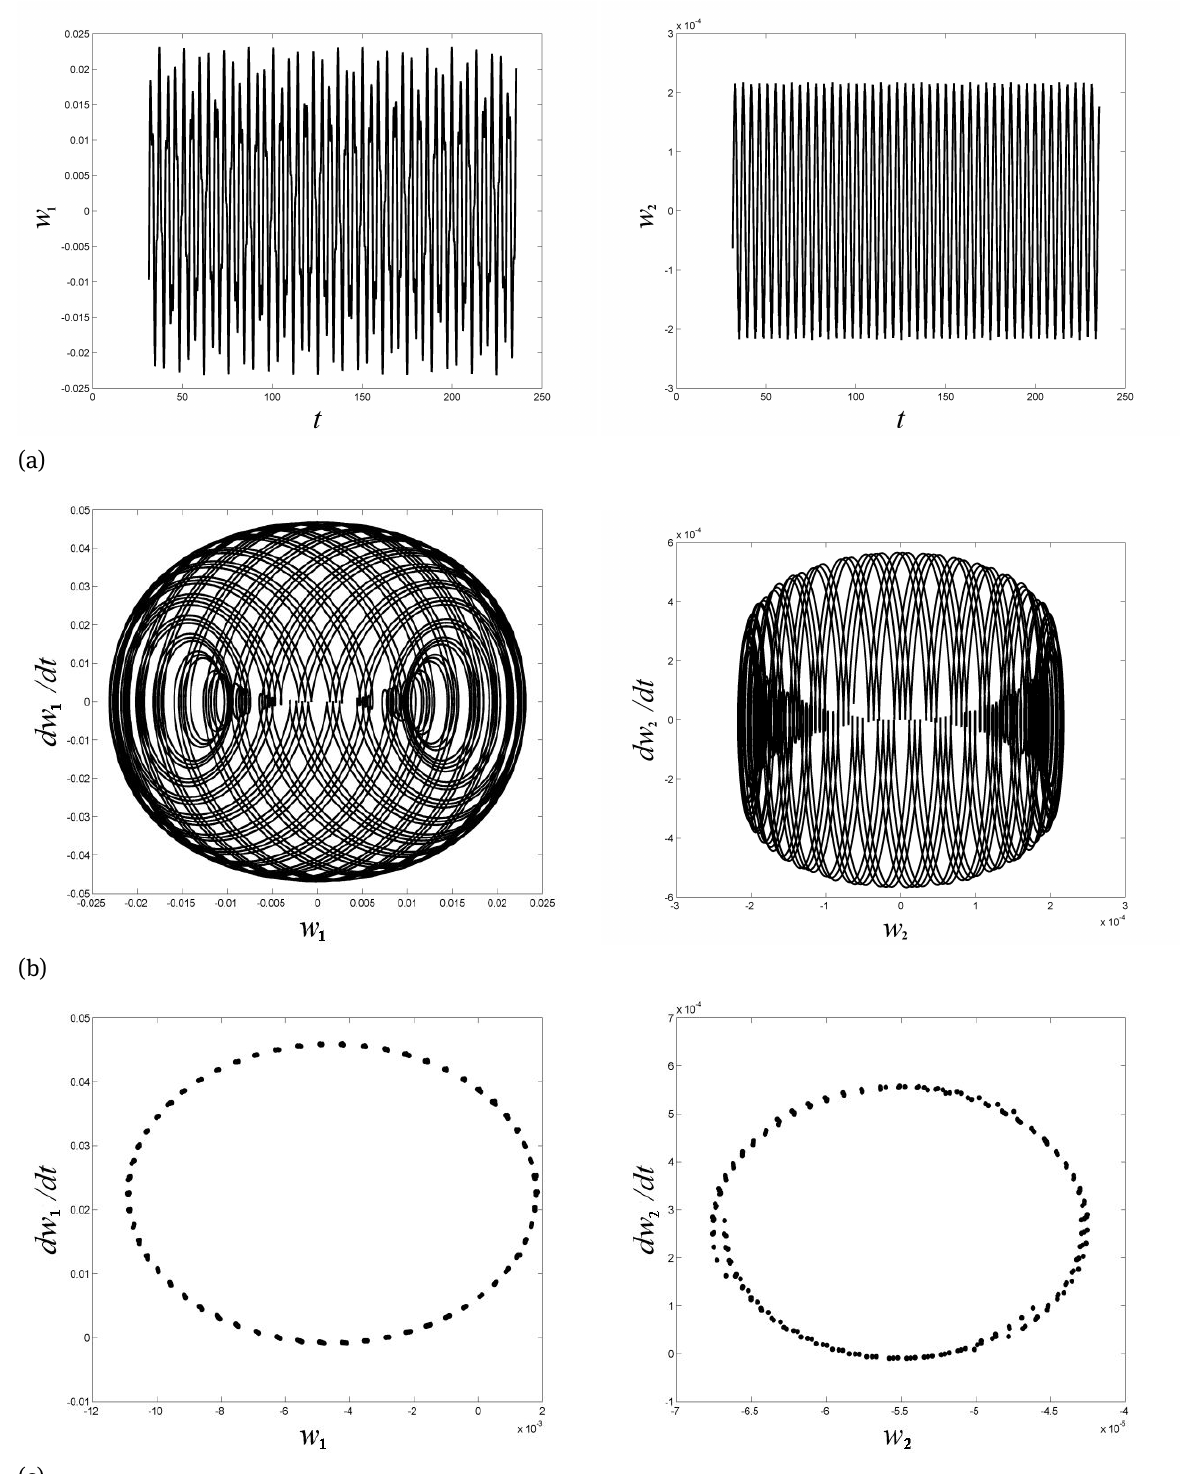
Fig. 8. Behaviors of the cantilever beam system in between period and quasiperiod, shown in wave diagrams (a), phase diagrams (b) and Poincaré maps (c). q = 79.43sin(20 πt )( Pa ) and e c = 2.8 × e 9 (cid:0) N / Nm 2 (cid:1)